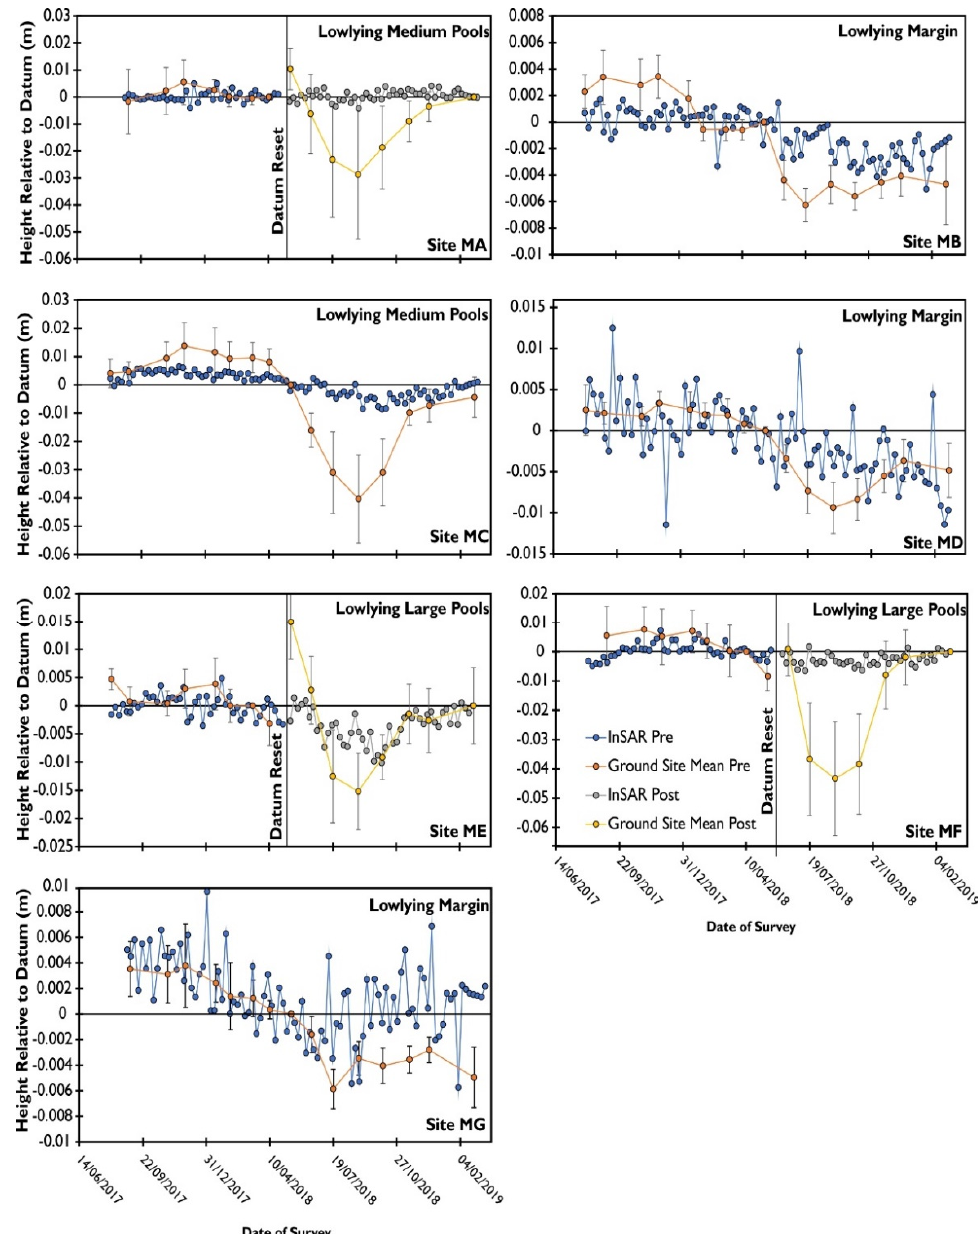
Figure 4. Comparison of APSIS InSAR derived and ground precise leveling (subsite mean) peatland surface motion data at the Low-lying Munsary Site. Graphs with dashed vertical line indicate a reset of datum in the InSAR data due to issues with ambiguity affecting phase unwrapping during the peak drought period. Details of datum dates for each site can be seen in Section 2 (Table 1).